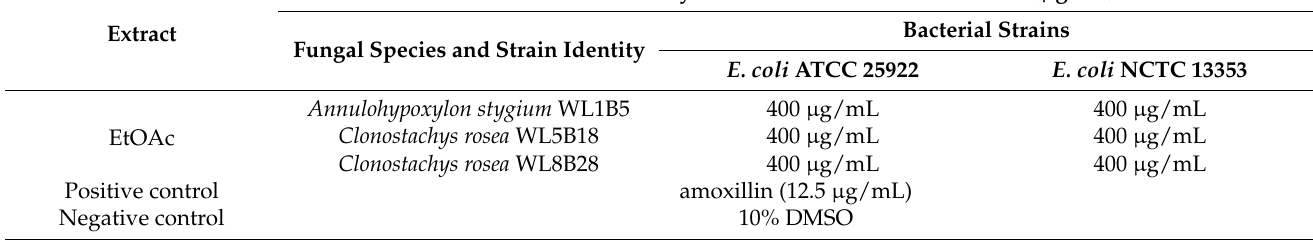
Table 4. Minimum inhibitory concentrations (MIC, µ g/mL) of extracts of selected fungi with antimi- crobial activity isolated from the Mind ú stream.